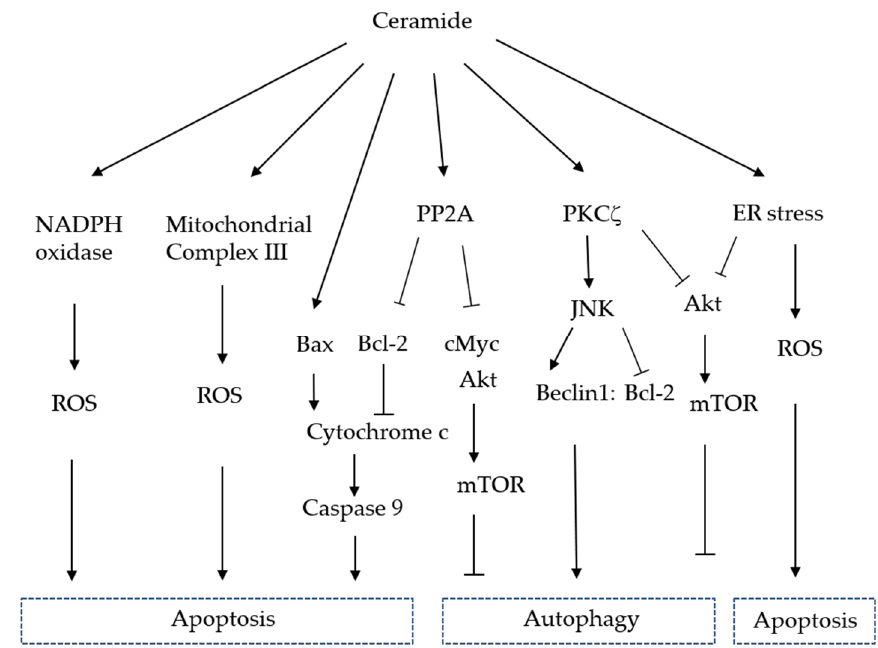
Figure 2. Outlines of ceramide-driven signaling pathways. Ceramide activates PP2A, which activates Bax and suppresses Bcl-2 to promote apoptosis. Ceramide suppresses Akt, inactivates downstream mTOR, and induces autophagy. Ceramide activates PKC ζ , which inhibits Akt phosphorylation and activates JNK. Activated c-Jun increases Beclin1 expression. Ceramide also increases NADPH oxidase- and mitochondrial complex III-mediated ROS production. NADPH oxidase, nicotinamide adenine dinucleotide phosphate oxidase; PP2A, protein phosphatase 2A; ER stress, endoplasmic reticulum stress; ROS, reactive oxygen species; mTOR, mammalian target of rapamycin.